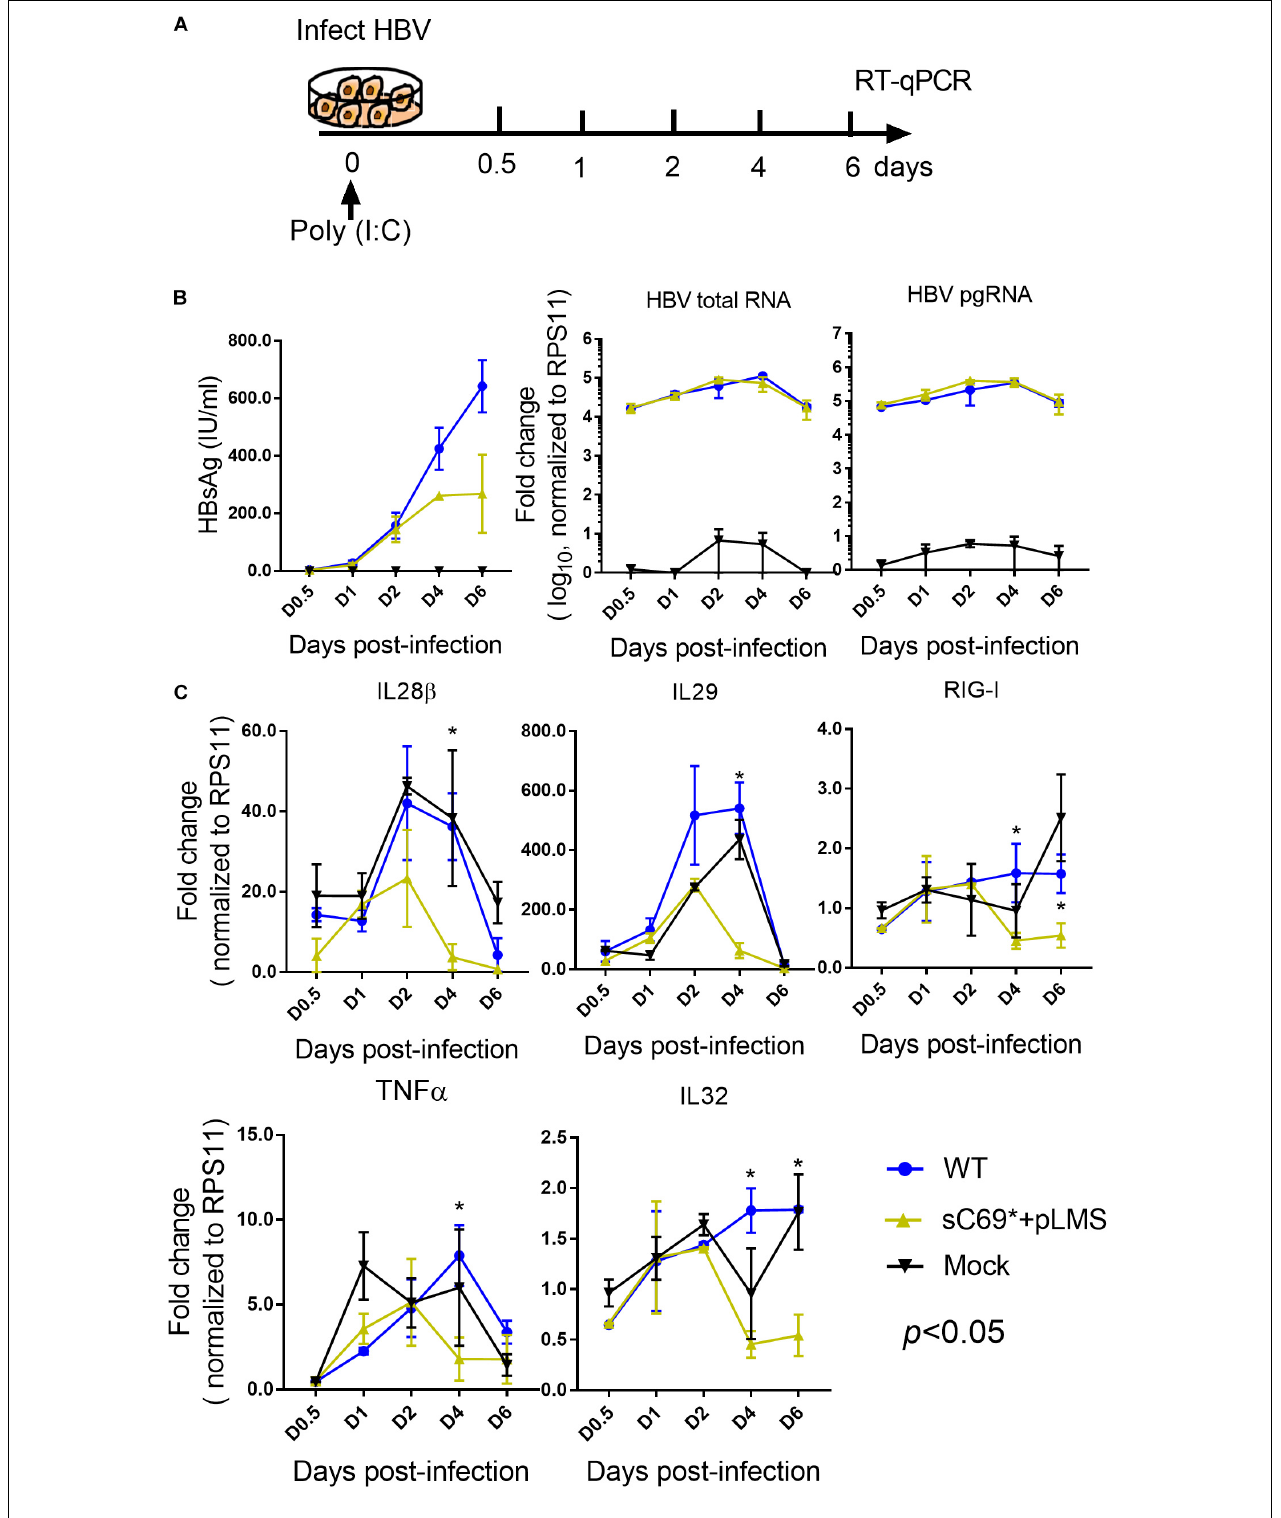
FIGURE 3 | The sC69 ∗ mutant attenuates the poly (I:C) inducing host immune response in HepG2-NTCP cells. (A) Schematic workflow for detecting ISGs expression during HBV WT and sC69 ∗ + pLMS infection with poly (I:C) treatment in HepG2-NTCP cells. Briefly, we collected virions from HBV WT and sC69 ∗ + pLMS transfections that were used to, infect HepG2-NTCP cells with 10 µ g/ml poly (I:C) during the infection and measured the viral and ISGs related